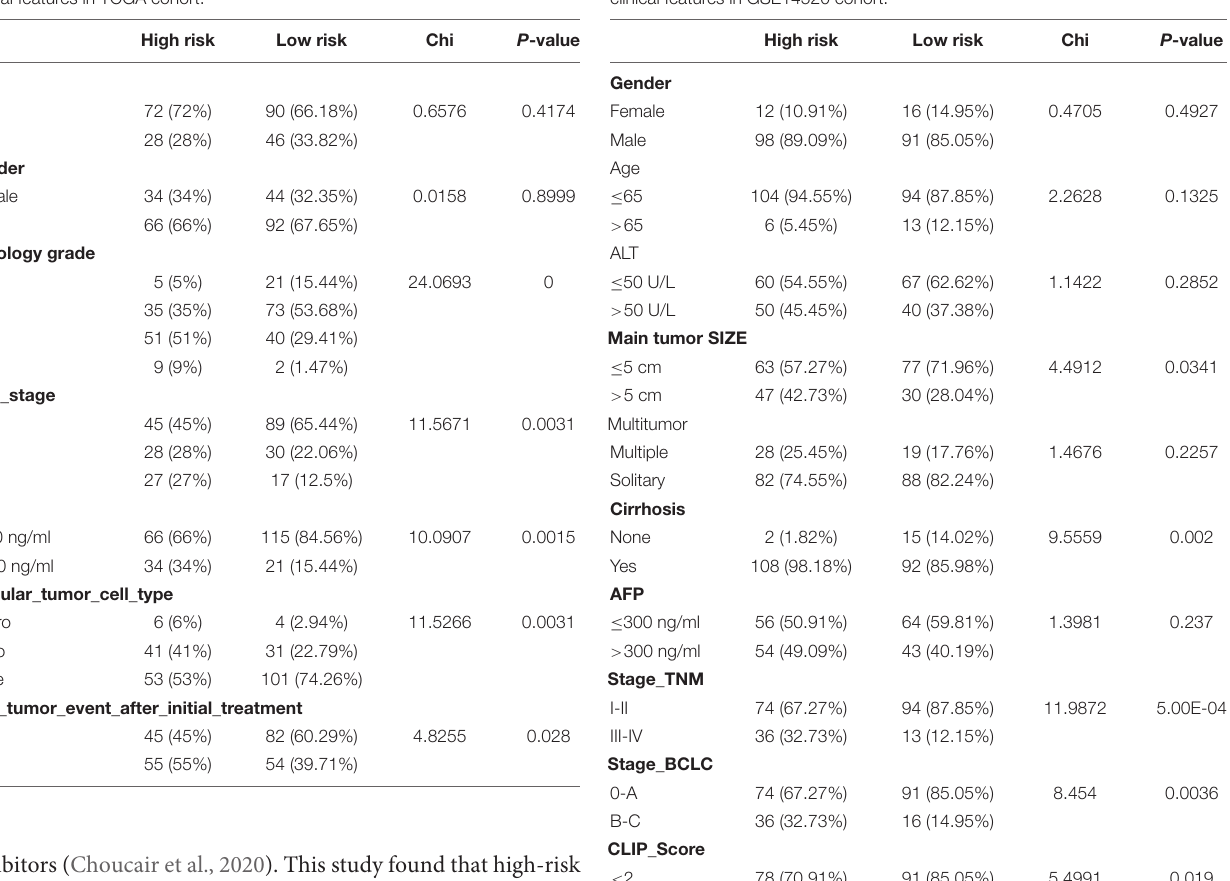
TABLE 2 | The chi-square test of the relation between different risk groups and clinical features in GSE14520 cohort.